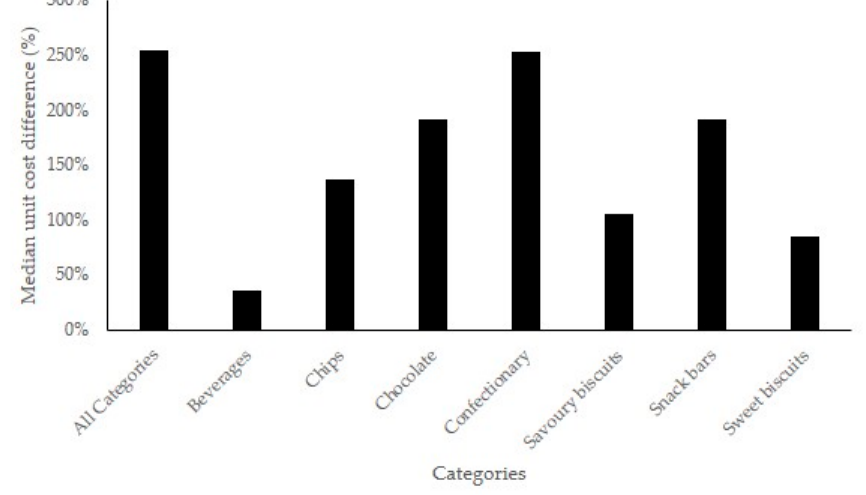
Figure 1. Median unit cost ($) per 100 g percent difference (%), per product category, between health